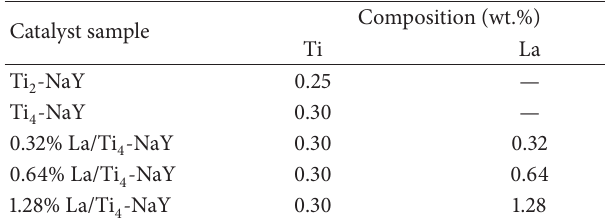
Table 2: Elemental composition of the prepared materials. Catalyst